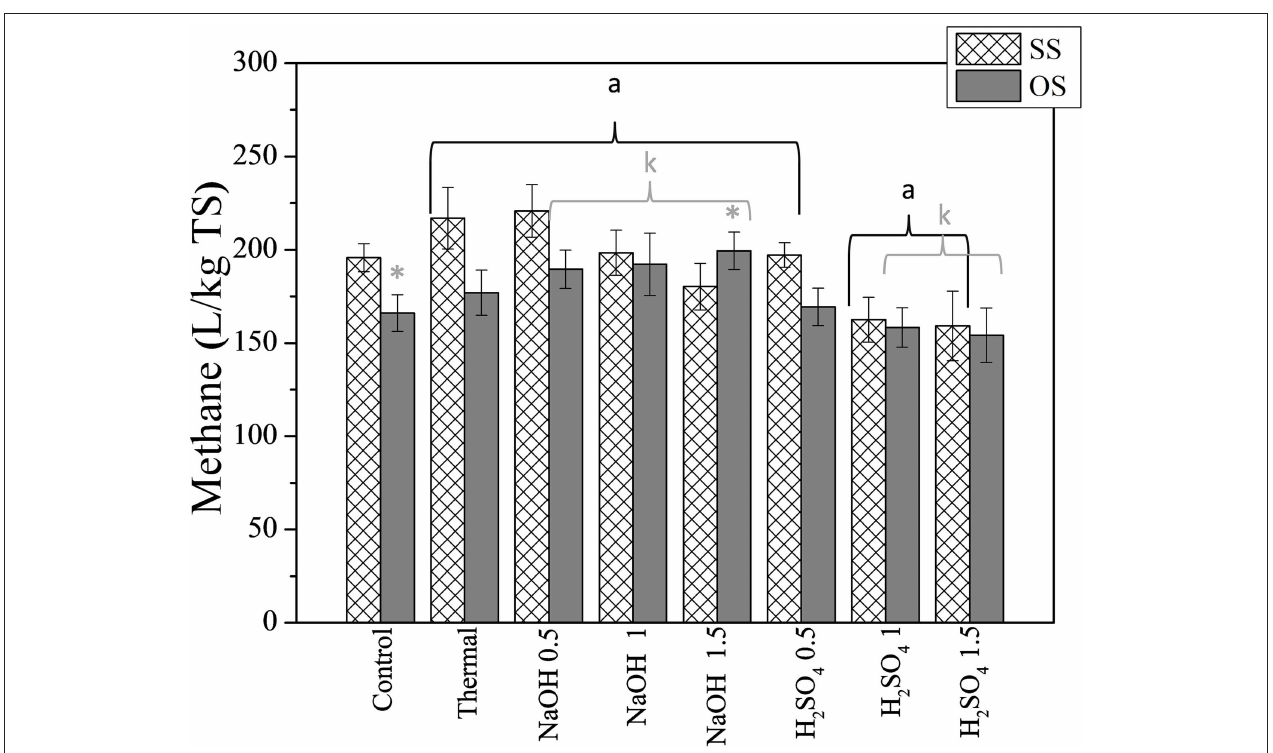
FIGURE 3 | The effect of thermochemical pretreatment on the methane potential of SS and OS. The results are mean ± SD from six different measurements ( N = 6). The statistical difference with the control (untreated biomass) is indicated by an asterisk above columns, whereas statistical difference among values is indicated by different letters above columns (Mann Whitney u